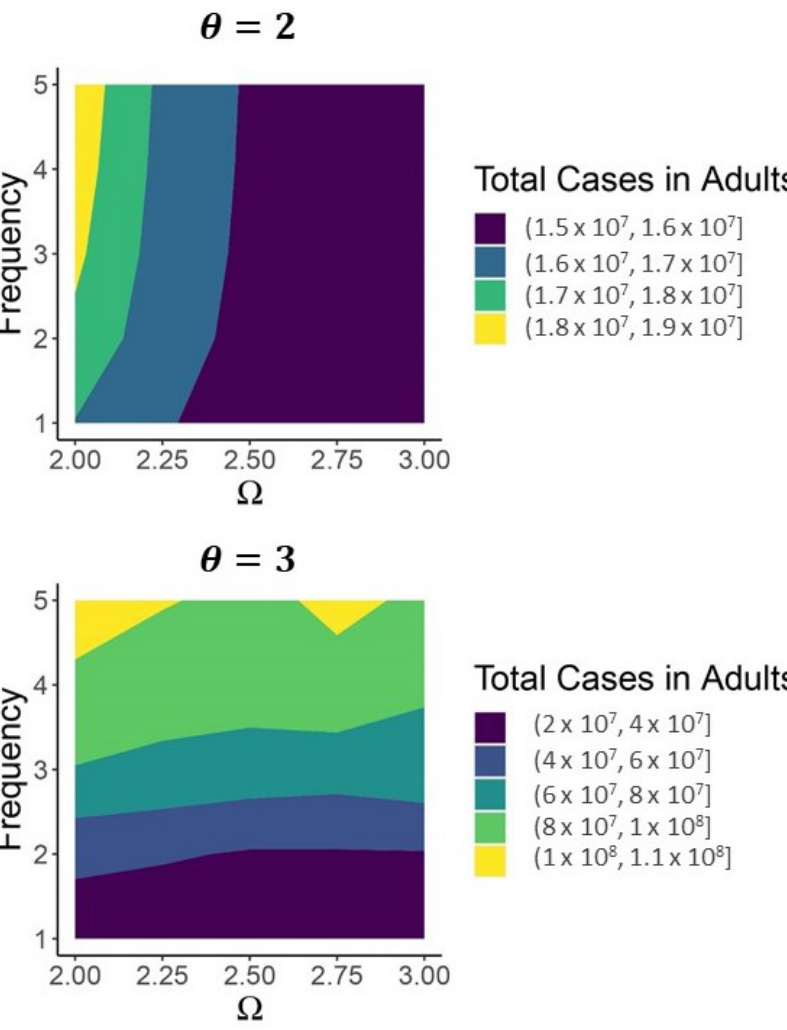
Figure 8. As long as high-shedding cases are not too infectious ( θ = 2) prolonged vaccination over the next thirty years is not necessary for SARS-CoV-2 to become JASC. If high-shedding cases are sufficiently infectious to cause periodic outbreaks ( θ = 3) then regular vaccination is necessary to limit high-shedding cases. Vaccination rate Ω is the number of doses (in the millions) administered to susceptible individuals per day during the intense vaccination program which begins on day 360 and lasts until day 460. After day 460, 60% of the population continues to get vaccinated at the corresponding Frequency (in years) along the vertical axis. Contact levels consistent with R 0 = 1.3 maintained from day 418 (16 March 2021) up to day 460, after which contact returns to levels consistent with R 0 = 2.5. In both panels Q ab = 0, Q am = Q kb = Q km = (cid:103) Q ab = (cid:103) Q am = (cid:103) Q kb = (cid:103) Q km = 1, and ν k =